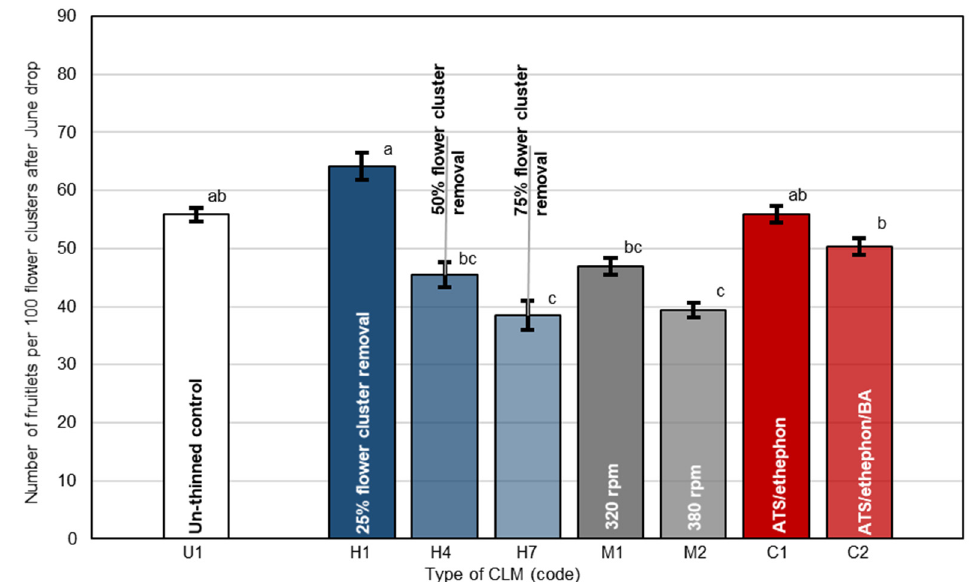
Figure 5. Effect of practical thinning methods on number of apple fruitlets after June drop per 100 flower clusters (color coding and explanations as for Figure 3).